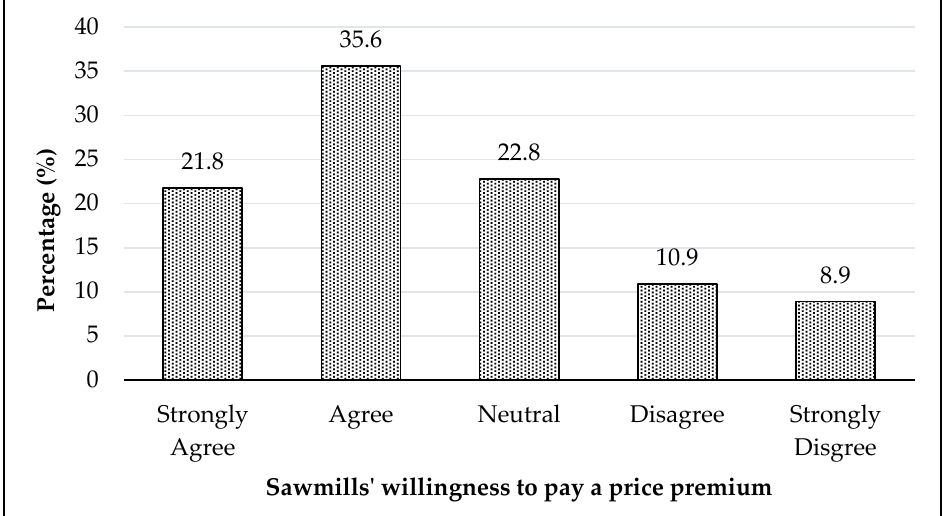
Figure 2. Sawmills’ willingness to pay price premiums for higher quality pine sawtimber grown on an extended rotation across the southeastern United States based on a 2018 mail survey.